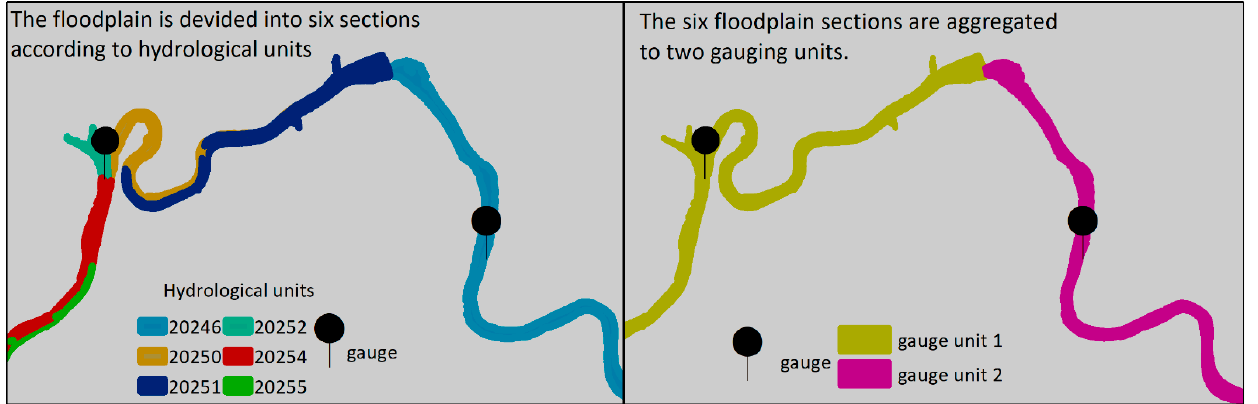
Figure 4. Scheme of applied small hydrological units ( left ) that can be aggregated belonging to one gauge, expressed as gauge unit, ( right ).